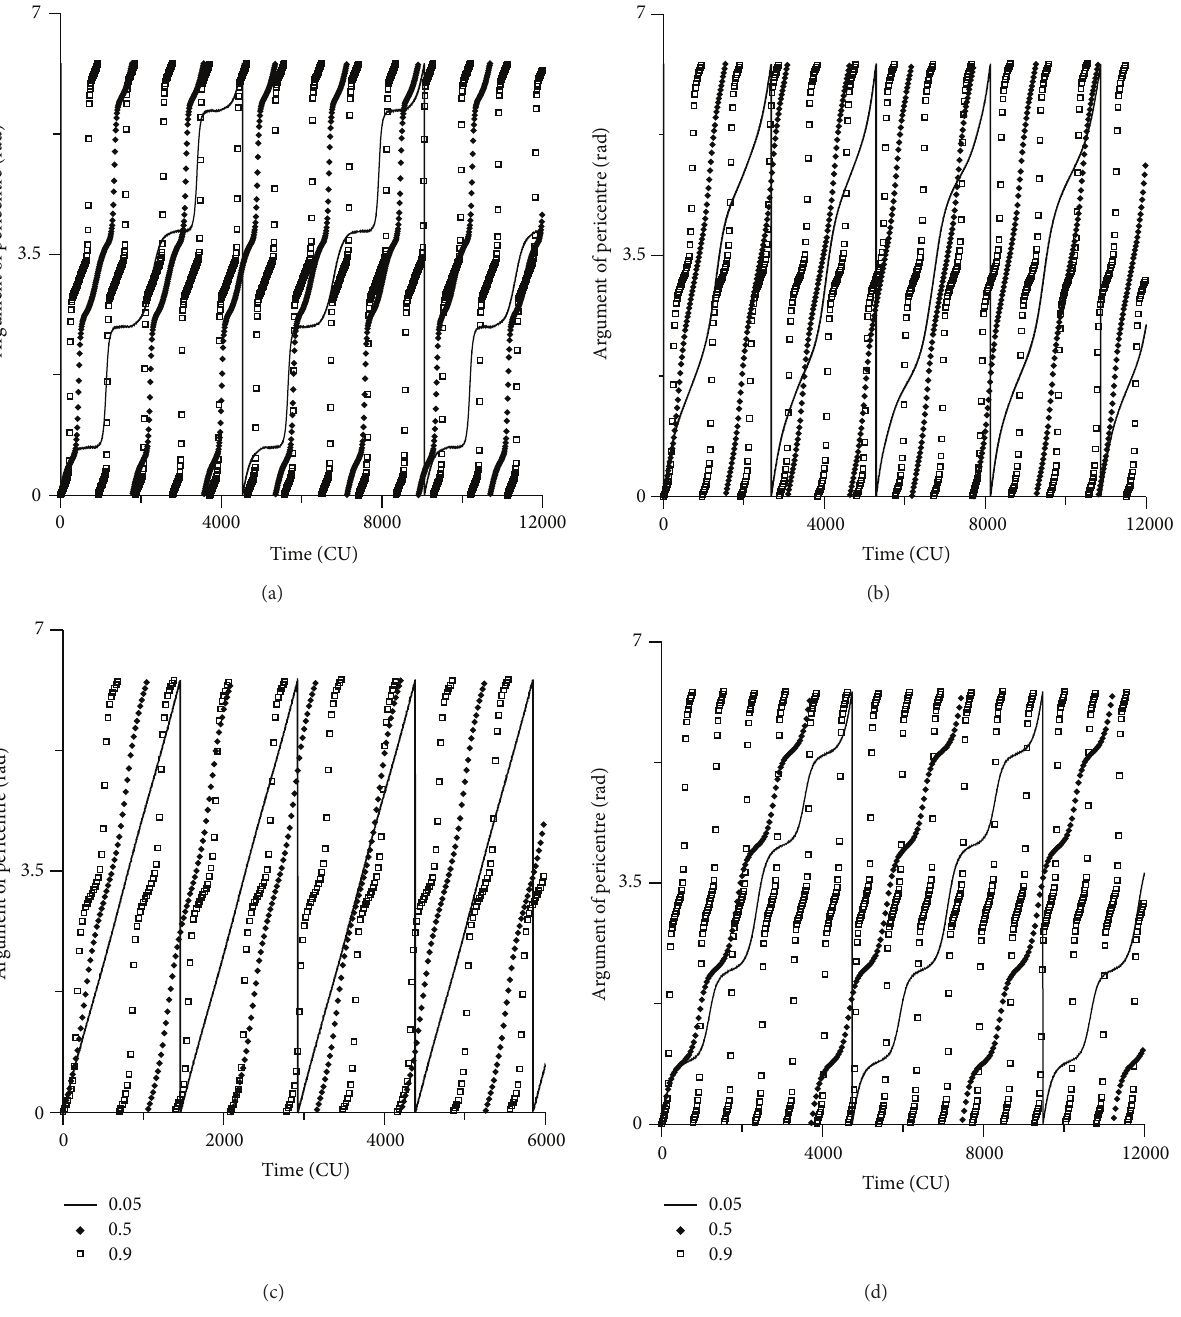
Figure 16: Behavior of the argument of pericenter for initial inclinations of 30 deg, 70deg, 130 deg, and 170 deg. Initial conditions are a = 0.341 canonical units, M 0 (0) = 0, 𝜔 (0) = 0, and Ω (0) = 0.